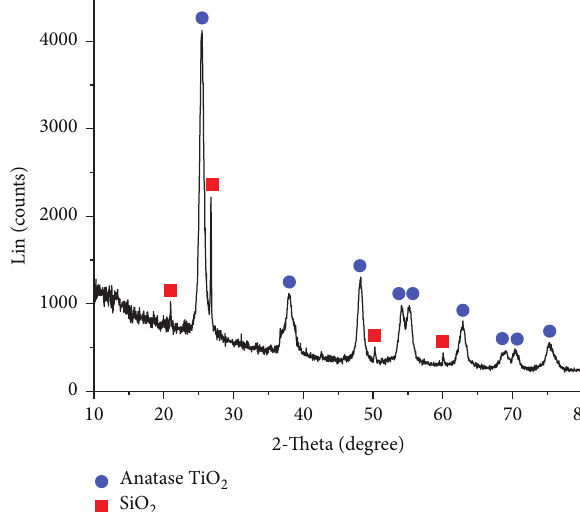
Figure 2: The XRD pattern of TiO 2 /GAC